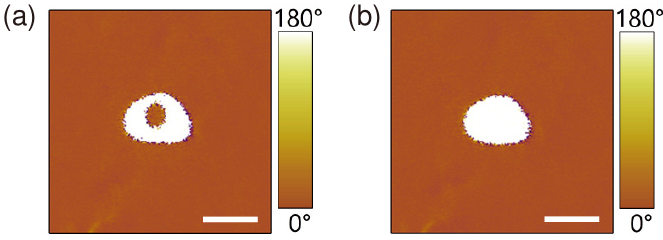
Figure 3. Typical PFM images for domains after the step-1 poling ( a ) and the step-2 poling ( b ), respectively. The magnitude and pulse duration of the poling fields were U DC 1 = 40 V, t p 1 = 1 s for the step-1 poling, and U DC 2 = − 55 V, t p 2 = 1 ms for the step-2 poling, respectively. Scale bar: 100